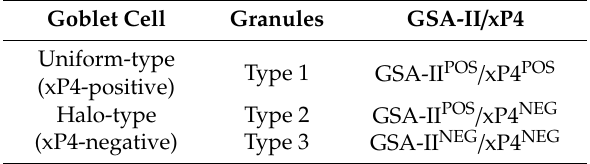
Table 1. Classification of goblet cell populations and secretory